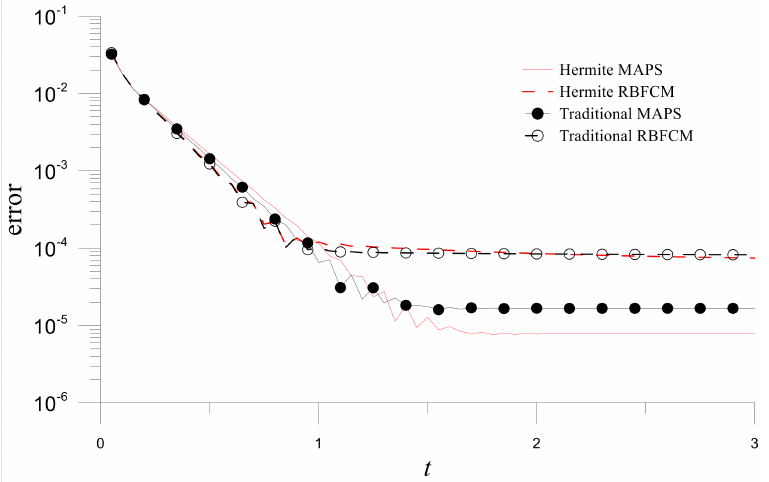
Figure 18. Time histograms of errors for numerical solutions obtained by the four methods in Example